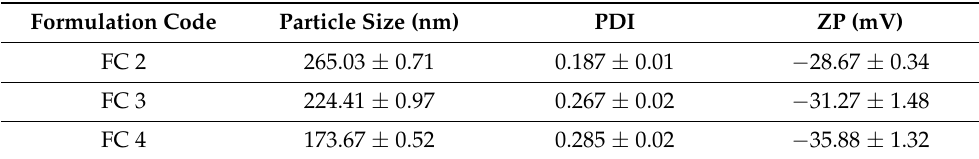
Table 2. The measured particle size, PDI, and ZP of the prepared β -ST-loaded CUB. Formulation